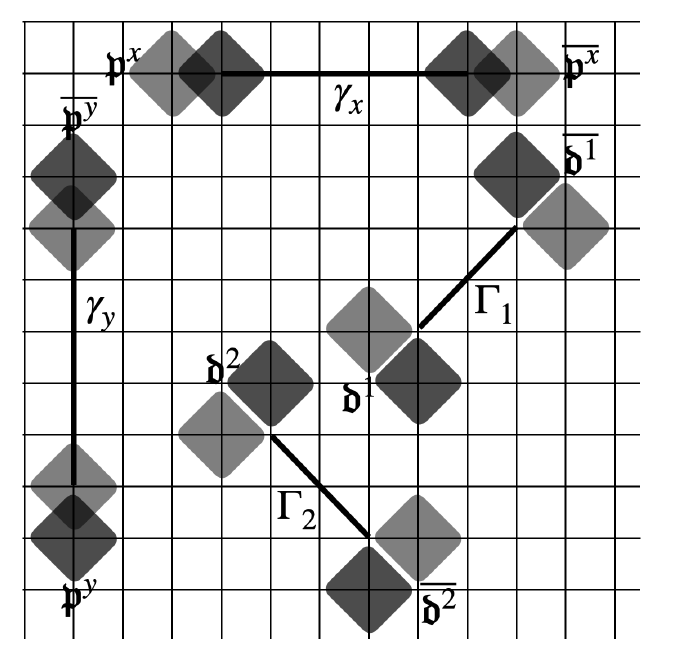
Figure 4: String operators V ( γ ) horizontally and vertically oriented and also S ( Γ ) , diagonally oriented. Darker diamonds represent positive charges while lighter ones represent negative